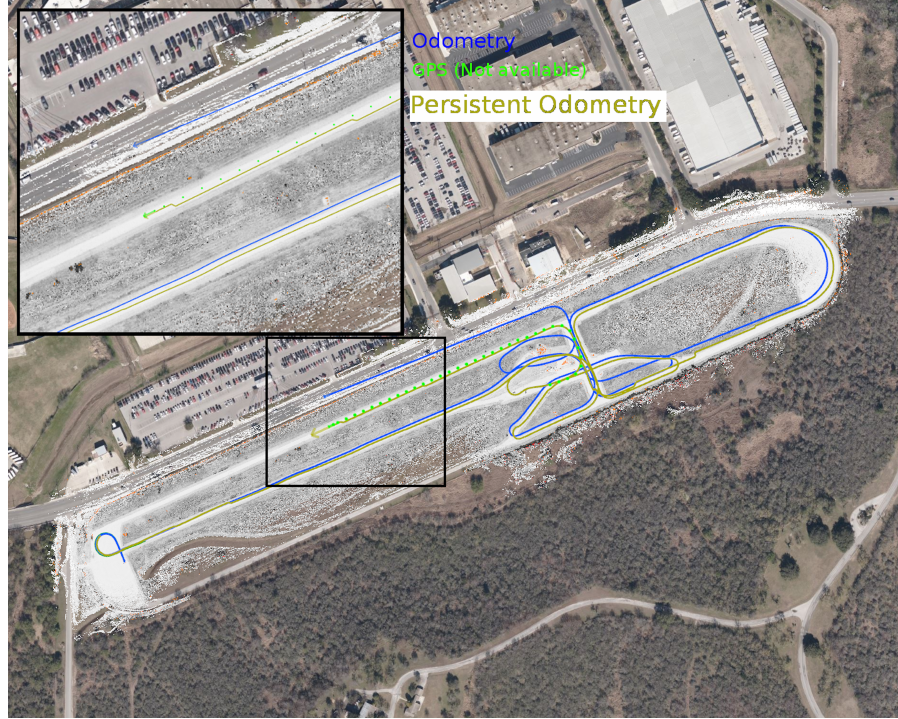
Figure 6. The result of localizing to an evolving map. This shows the result of retraversing a previ- ously explored area, and localizing to the persistent map. The localization track is 2.3 km long, ending in an olive arrow inside the region inset in the upper left of the figure. This arrow is approximately 1.0 m from the GPS location at this point in time, shown by a light green dot. The odometry track is also 2.3 km long, ending in a blue arrow in the main road bordering the test track, approximately 32.8 m north and slightly west of the current GPS location. The satellite imagery and GPS coordinates (green dots) are shown only for context, and are not available to the